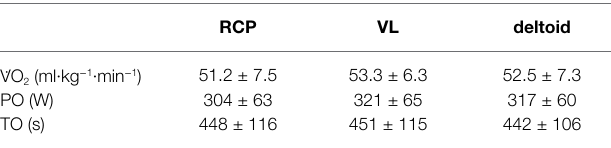
TABLE 2 | Mean comparison between respiratory compensation point (RCP), vastus lateralis (VL), and deltoid Deoxy-BP as a function of V ̇ O2, power output (PO), and time of occurrence (TO).